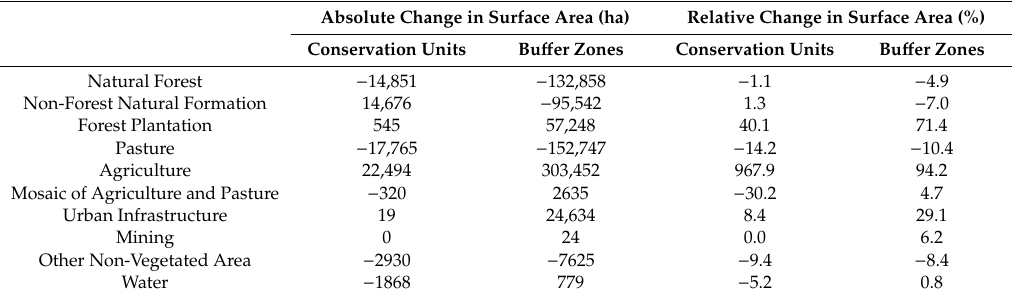
Table 3. Absolute and relative change in surface area of the 10 land use and land cover (LULC) categories in the conservation units and their 10 km bu ff er zones between 2001 and 2016. Absolute Change in Surface Area (ha) Relative Change in Surface Area (%) Conservation Units Bu ff er Zones Conservation Units Bu ff er Zones Natural Forest − 14,851 − 132,858 − 1.1